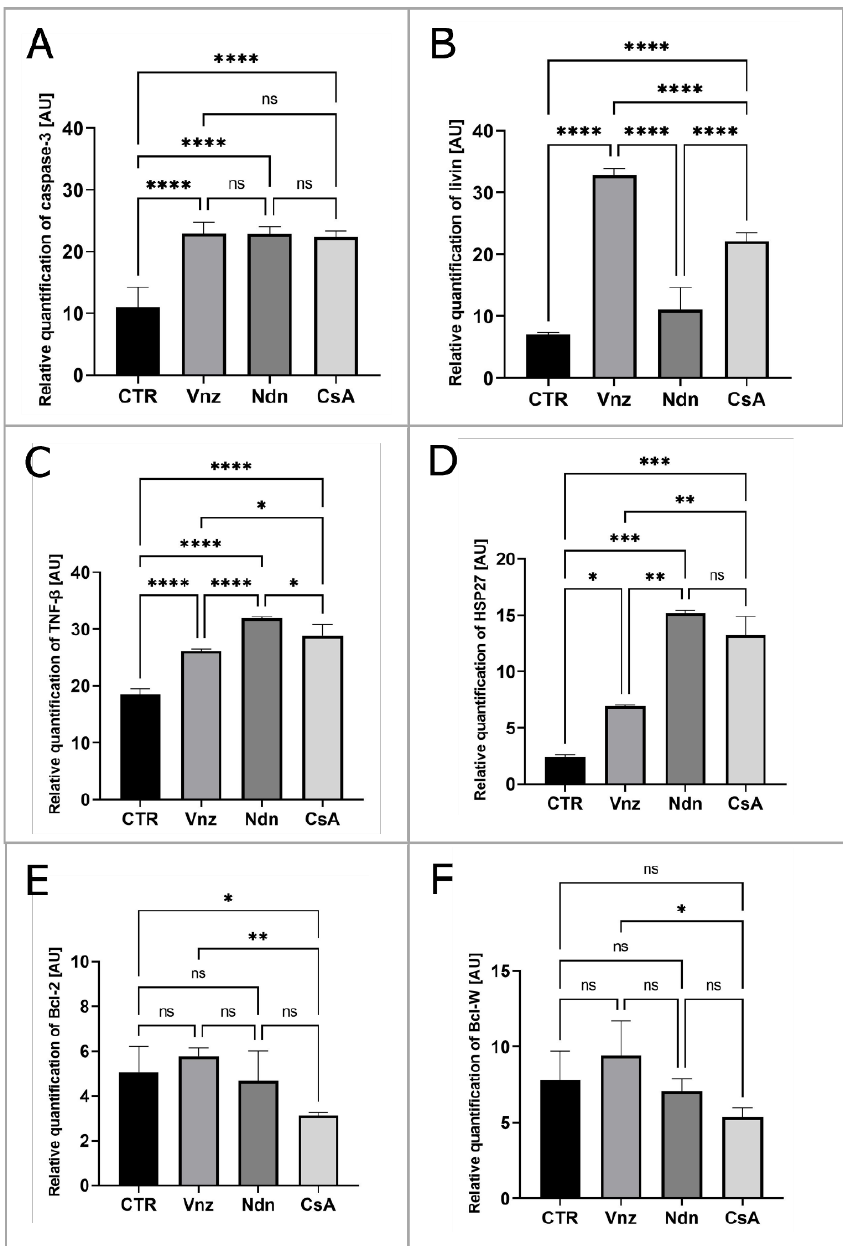
Figure 2 . Apoptosis array analysis at the level of total protein in porcine COCs subjected to the IVM procedure using a 3D culture model (alginate capsules) in control cultures (CTR) or in experimental cultures: in the presence of vinclozolin (Vnz), nandrolone (Ndn) or cyclosporin A (CsA). The graphs show the relative content of caspase 3 ( A ), livin ( B ), TNF-β ( C ), HSP27 ( D ), Bcl-2 ( E ) and Bcl-w ( F ) proteins obtained from measurements of the optical density of the spots representing a specific signal after normalization against the positive control. Results represent the mean with n = 5 ± standard deviation (SD); each “ n ” consisted of 200 COCs. Statistical analysis: homogeneity of variance—Brown–Forsythe test; normality of distribution—Bartlett’s test and one-way ANOVA followed by Dunnett’s post hoc test, * p < 0.05, ** p < 0.01, *** p < 0.001, **** p < 0.0001; ns-non—significant.